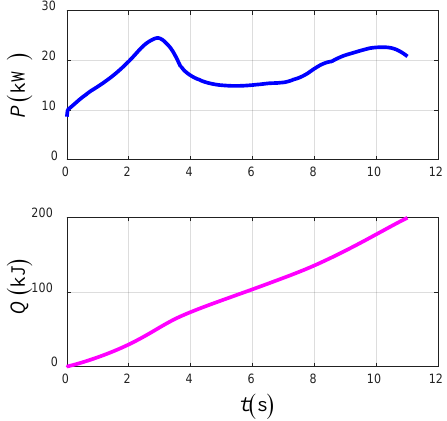
Figure 23. The power and energy consumption in TTO.